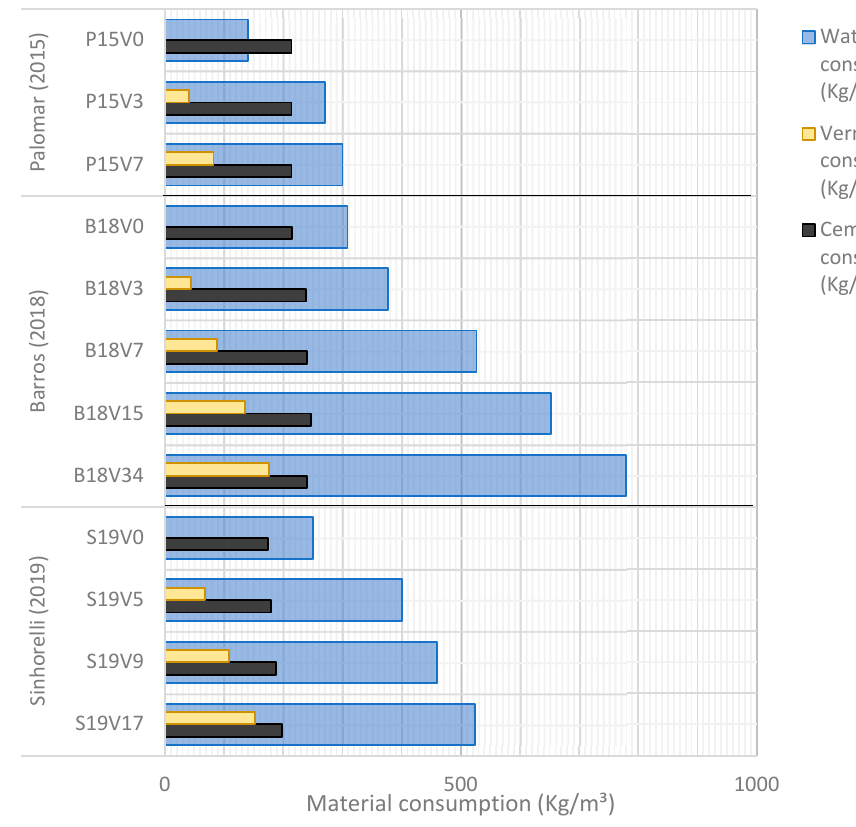
1000S19V17S19V9S19V5S19V0B18V34B18V15B18V7B18V3B18V0P15V7P15V3P15V0 0 500 Figure 5. Correlation of water, cement, and vermiculite consumption [14,44,45]. Figure 5. Correlation of water, cement, and vermiculite consumption